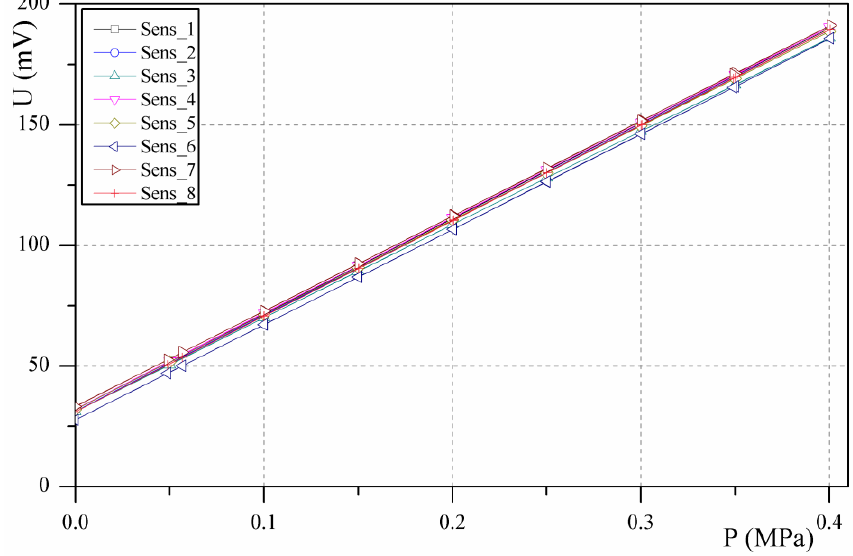
Figure 7. Output voltage of the pressure-sensor elements for a 5 V